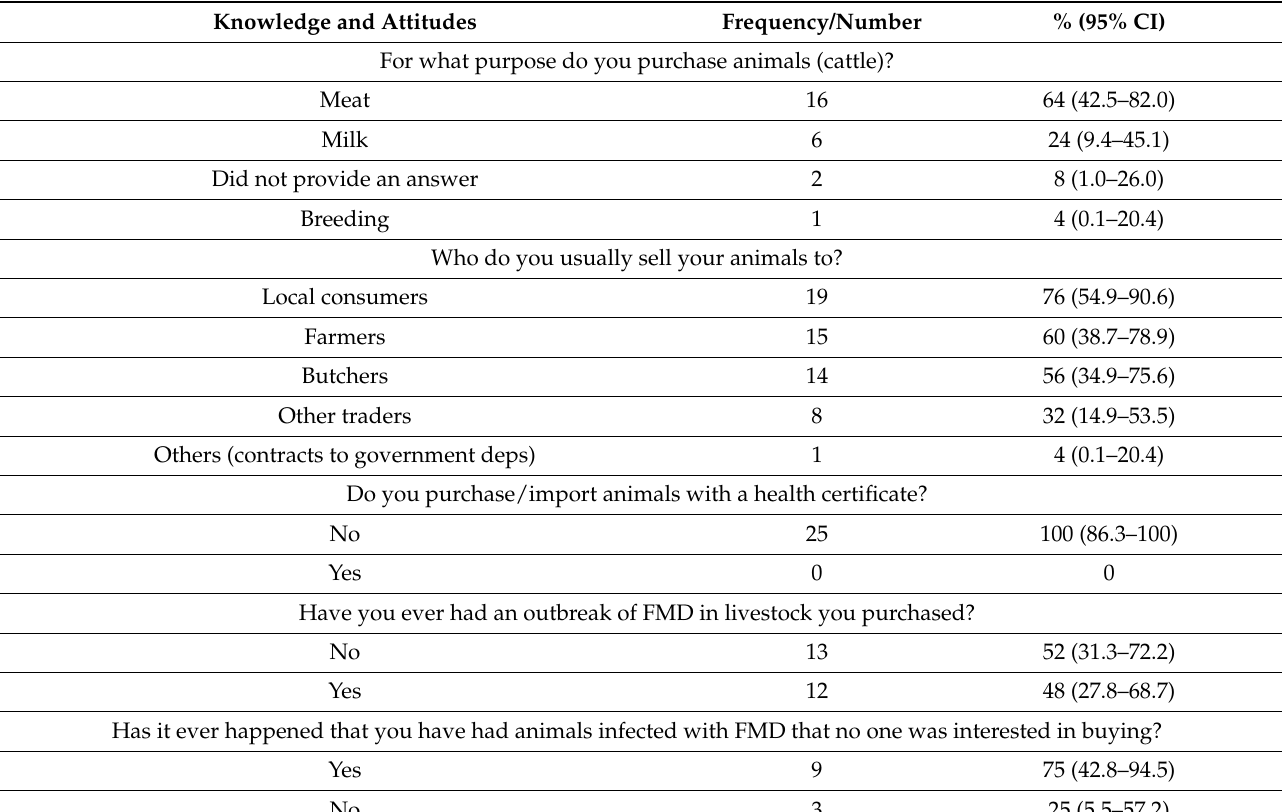
Table 3. Traders’ ( n = 15) and butchers’ (butchers in Baghlan province purchased live animals for their business, therefore they were also considered as animal traders.) ( n = 10) responses related to their knowledge and attitudes on foot and mouth disease